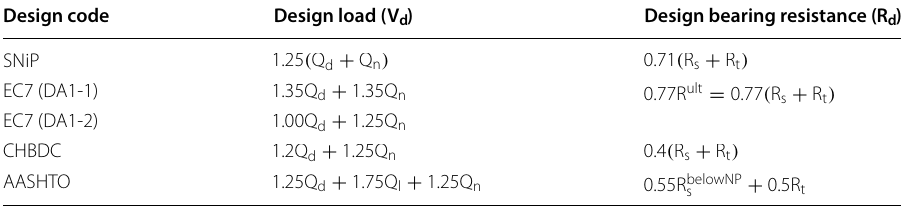
Where Q d is a dead load, kN; Q l is a live load, kN; Q n is a drag force, kN; R s is a shaft resistance, kN; R belowNP s is a shaft resistance below NP, kN; R t is a tip resistance, kN; R ult is an ultimate bearing resistance, kN